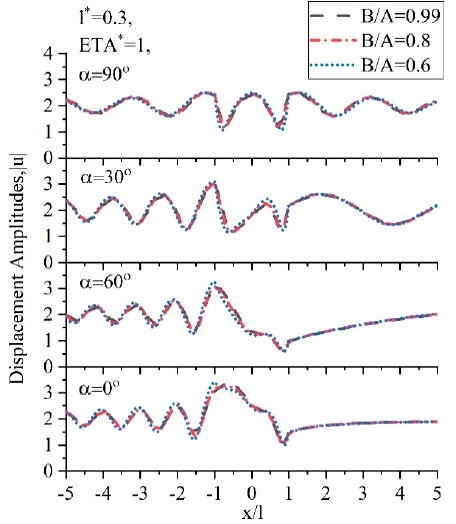
Figure 8. Comparison of displacement amplitudes of canyons belonging to ellipses with different axial ratios when l ∗ = 0.3 and ETA ∗ = 1 .